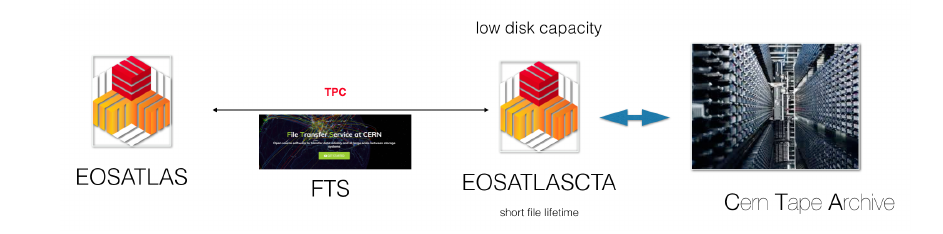
Figure 4. EOS / CTA deployment model with disk-only and tape-enabled EOS instances